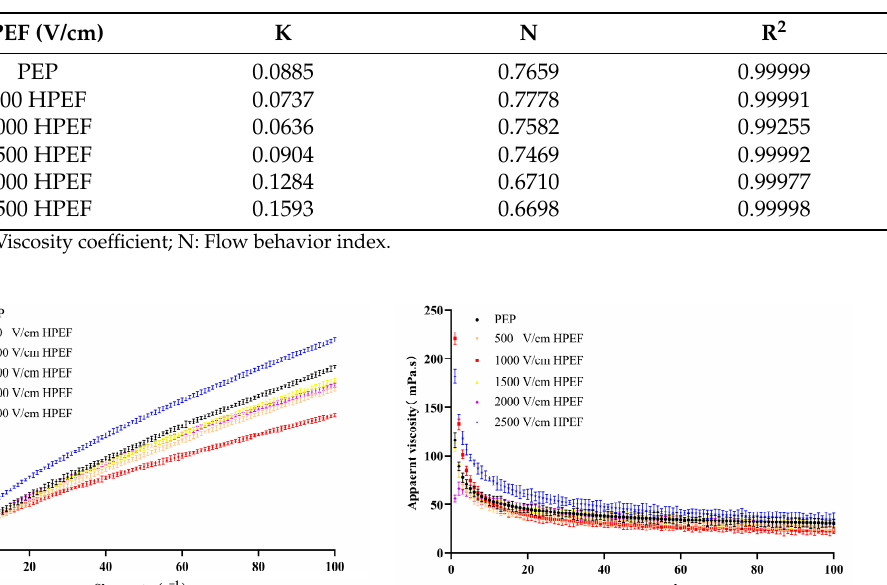
Table 2. Power-law model of PEP under different HPEF (500, 1000, 1500, 2000, and 2500 V/cm)